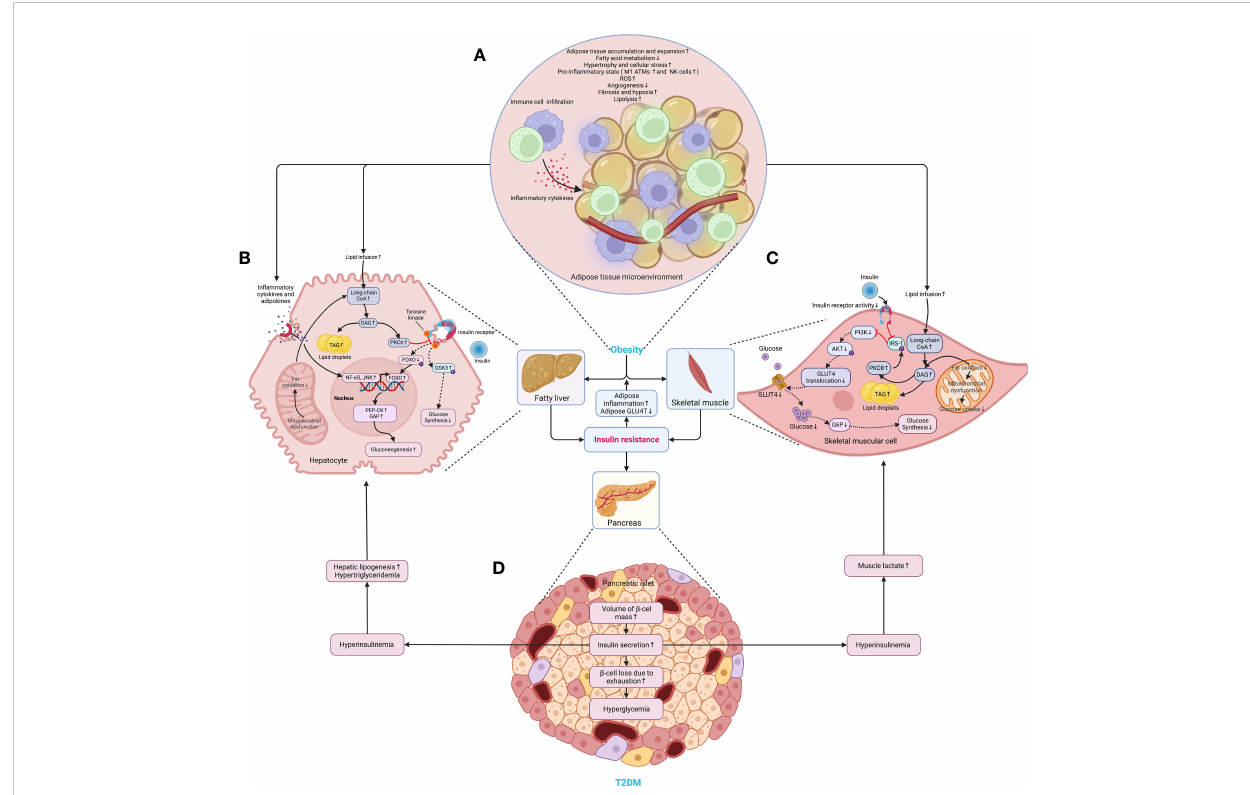
FIGURE 2 The critical roles of obesity-induced insulin resistance in the consequent pathogenesis of T2DM. (A) The aberrant accumulation and expansion of adipose tissue in obesity create a microenvironment characterized by hypoactive fatty acid metabolism and fuel cellular stress and pro-in fl ammatory perturbations, which results in an increased lipolysis, oxidative stress, and hypoxia due to fi brosis and insuf fi cient angiogenesis. (B) In the liver, the excessive infusion resulting from enhanced lipolysis within adipose tissue causes a transient increase in DAG, which occurs once the rates of DAG synthesis exceed rates of mitochondrial long-chain CoA oxidation under mitochondrial dysfunction, and then the DAG is synthesized into TAG and stored as lipid droplets. Meanwhile, DAG activates PKC ϵ and blunts the insulin receptor tyrosine kinase, damaging insulin signaling and decreasing insulin-stimulated glycogen synthesis owing to reduced phosphorylation of GSK3. At the same time, it also dampens the activity of glycogen synthase and indulges hepatic gluconeogenesis through decreased phosphorylation of FoxO, where the increased FoxO translocates to the nucleus and enhances the gene transcription of gluconeogenic enzymes, such as PEP-CK and G6P (39). Similarly, the cytokines and adipocytokines released in systemic in fl ammation increase hepatic gluconeogenic enzyme transcription by activating NF- k B and JNK. (C) In the skeletal muscle, the increased lipid fusion results in the accumulation of intracellular long-chain CoA and elevates the level of DAG, which is also caused by the decline in fat oxidation owing to mitochondrial dysfunction and subsequent reduction in glucose uptake. Apart from increasing the synthesis of TAG as cellular lipid storage, DAG also activates the theta isoform of protein kinase C (PKC q ), which leads to increased phosphorylation of IRS-1 and hinders insulin signaling and subsequent activation of the PI3K/AKT pathway, dampening glucose transport and glycogen synthesis. (D) While obesity- induced insulin resistance exacerbates in fl ammation and glucose transport in adipose tissue, the volume of b -cell mass is increased to meet the growing demand for insulin secretion. However, the increased insulin secretion results in hyperinsulinemia afterward and exasperates both hepatic and systemic lipid accumulation. Moreover, hyperinsulinemia increases the level of lactate in muscles, which is released into circulation and used as a substrate for hepatic lipogenesis. Finally, b -cells collapse, and the de fi ciency of insulin secretion leads to hyperglycemia. AKT, protein kinase B; ATM, adipose tissue macrophage; CoA, acetyl coenzyme A; DAG, diacylglycerol; FoxO, forkhead box subgroup O; G6P, glucose 6-phosphate; GLUT4, glucose transporter type 4; GSK3, glycogen synthase kinase 3; IRS-1, insulin receptor substrate 1; JNK, Jun N-terminal kinase; NF- k B, nuclear factor k B; NK, natural killer (cell); P, phosphorylation; PEP-CK, phosphoenolpyruvate carboxykinase; PI3K, phosphatidylinositol-3-kinase; PKC ϵ ( q ), epsilon (theta) isoform of protein kinase C; ROS, reactive oxygen species; TAG,